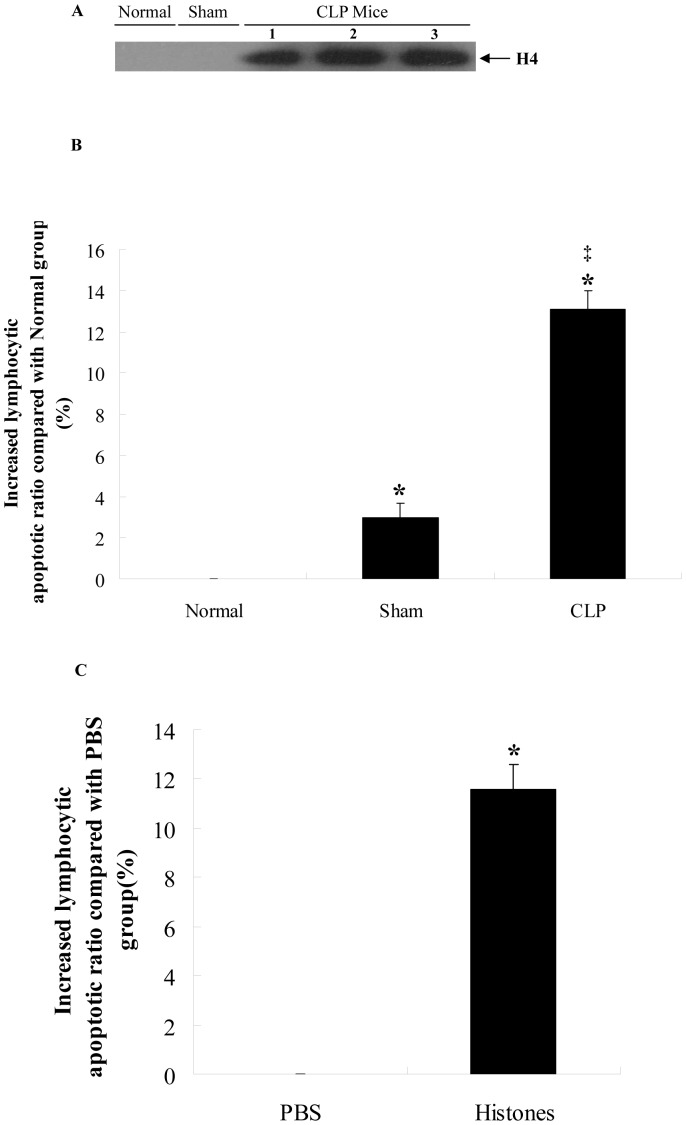
Lymphocyte apoptotic ratio was increased by extracellular histones in CLP mouse model.A. The levels of plasmic histone H4 of normal, sham or CLP mice were detected by western blotting 6± SD (n = 3). *p<0.05, as compared with normal group. ‡
p<0.05, as compared with Sham group. C. Histones were injected into mice at the dose of 60 mg/kg weight. Lymphocytes were separated from whole blood 6 h after injection for apoptosis analysis by flow-cytometry. Values are presented as means ± SD (n = 6). *p<0.05, as compared with PBS group.